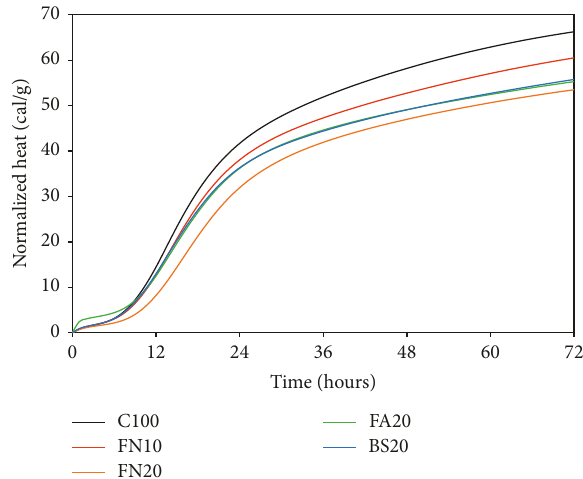
Figure 5: Heat of